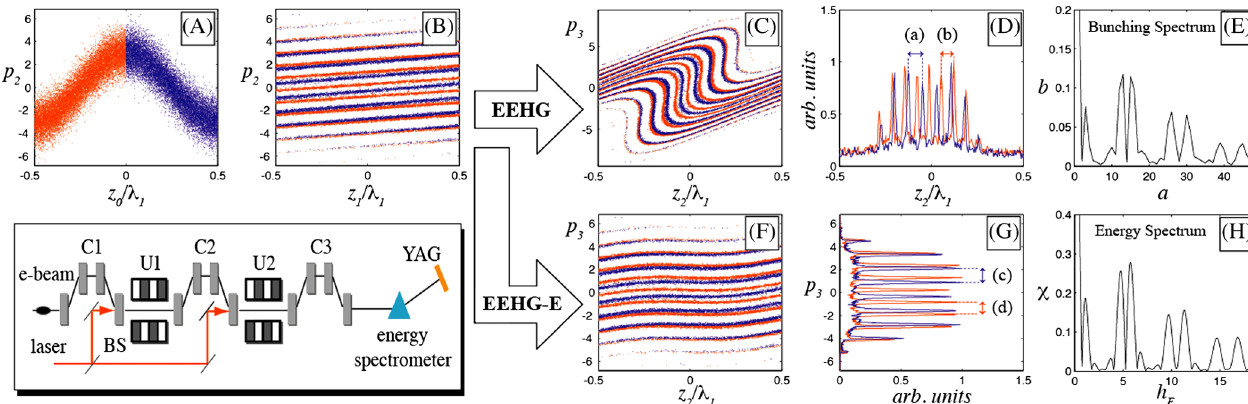
FIG. 1 (color online). Lower left: Diagram of the EEHG-E experiment at the Next Linear Collider Test Accelerator (NLCTA). The sinusoidal energy modulation (A) generated in U1 is strongly dispersed (B) as the beam travels through C2. In U2, a second modulation is used to either rotate the energy bands upright after C3 (C) to generate harmonic density bunching (D) for EEHG, or to flatten the energy bands (F) to generate observable peaks in the projected energy (G) at the YAG screen in EEHG-E. Blue and red regions of different initial chirp lead to differently spaced peaks in the energy projection [(c) and (d), respectively] or density projection [(a) and (b)]. The harmonic frequency content of the EEHG density bunching (E) and EEHG-E energy banding (H) show similar